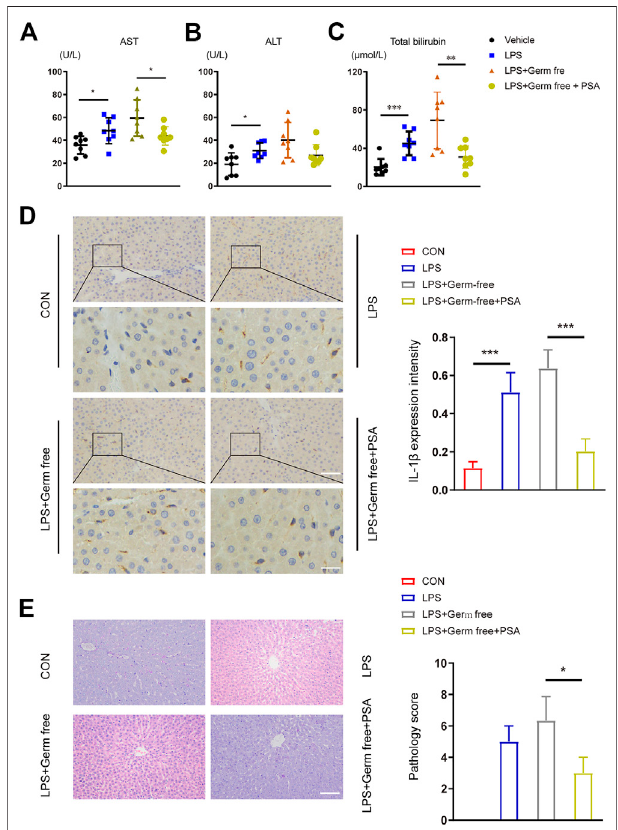
FIGURE 5 | Hepatic function and histological analysis of the livers after intravenous administration of LPS with or without PSA in mice. (A – C) Plasma chemistry pro fi le analyses of aspartate transaminase (AST) (A) alanine transaminase (ALT) (B) and total bilirubin (C) after VRC treated 5 days (D) Left: Immunohistochemical (IHC) detection of hepatic IL-1 β (200 × upper and 400 × down), Right: IL-1 β expression intensity in different treated groups were analyzed (E) Left: Photomicrographs of stained with H&E (200 × ). Right: Semiquantitative pathology scoresoflivertissues.* p < 0.05, ** p < 0.01, *** p < 0.001; Unpaired t